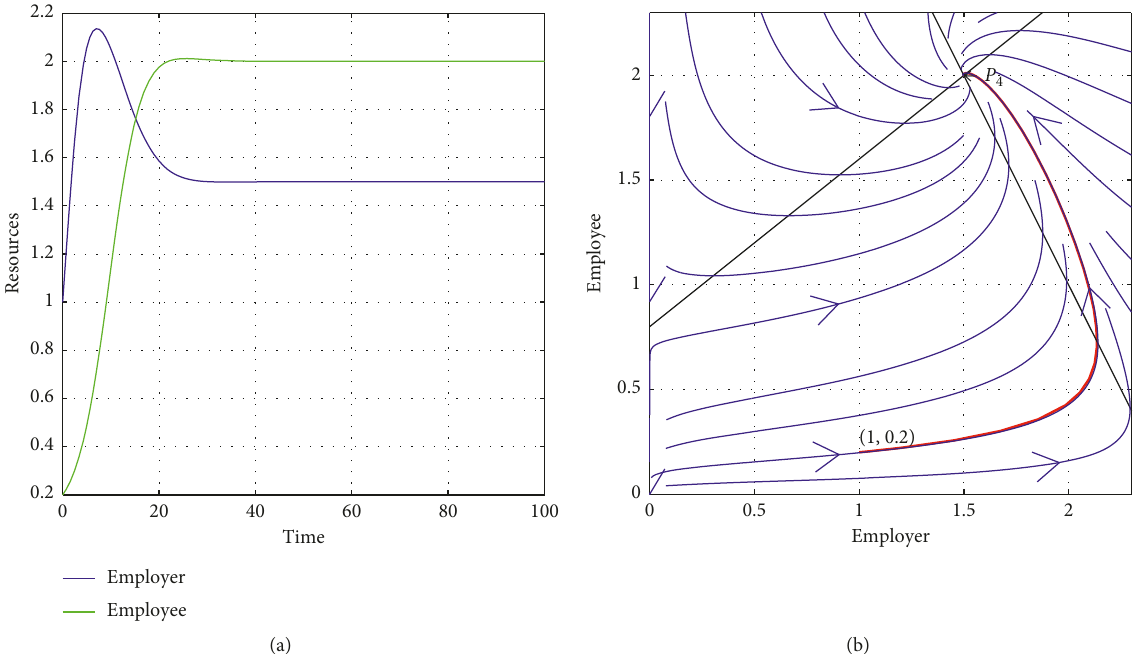
Figure 6: The simulation result and the phase diagram in the win-win situation ( b